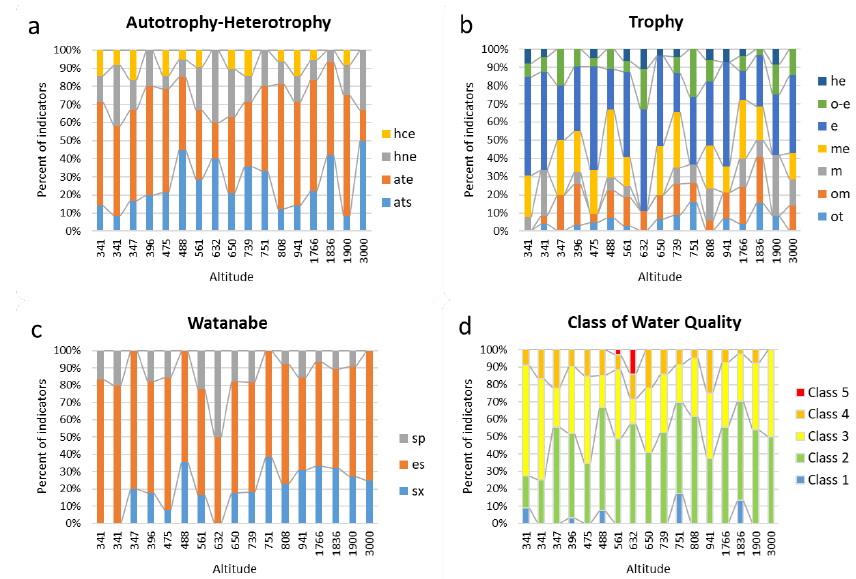
Figure 8. Dynamic of indicator species percentage in the communities across the study sites: ( a ) nutrition type indicators (ats — nitrogen – autotrophic taxa, tolerating very small concentrations of organically bound nitrogen; ate — nitrogen – autotrophic taxa, tolerating elevated concentrations of organically bound nitrogen; hne — facultatively nitrogen – heterotrophic taxa, needing periodically elevated concentrations of organically bound nitrogen, hce — facultatively nitrogen – heterotrophic taxa, needing elevated concentrations of organically bound nitrogen); ( b ) trophic state indicators (ot — oligotraphentic; om — oligo – mesotraphentic; m — mesotraphentic; me — meso – eutraphentic; e — eutraphentic; o – e — oligo – eutraphentic; he — hypereutraphentic); ( c ) organic pollution diatom indicators (sx — saproxenes, es — eurysaprobes, sp — saprophiles); ( d ) class of water quality indicators.